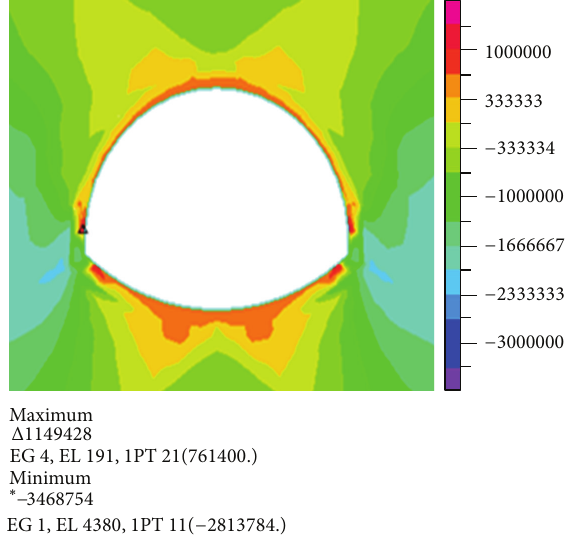
Figure 7: Nephogram of the first principal stress.